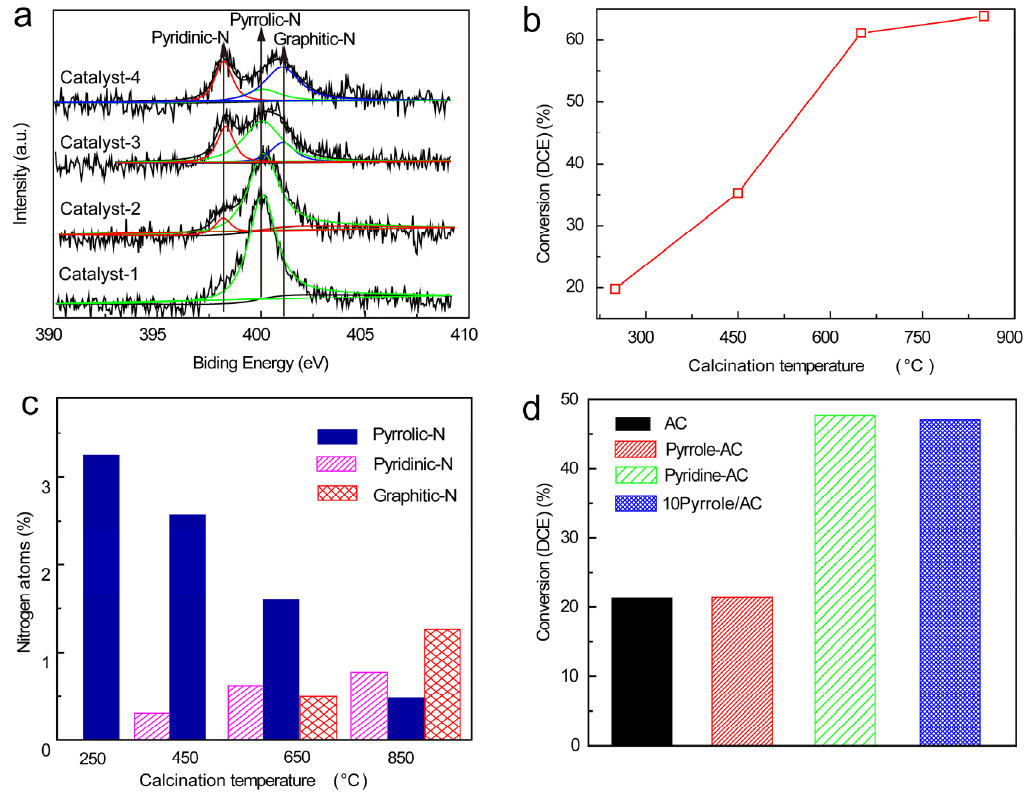
Figure 3. ( a ) High-resolution N1s spectra of 30Pyrrole/AC catalysts calcinated at 250, 450, 650, and 850 °C. ( b ) 1,2-dichloroethane (DCE) conversion over N@AC catalysts calcinated at 250, 450, 650, and